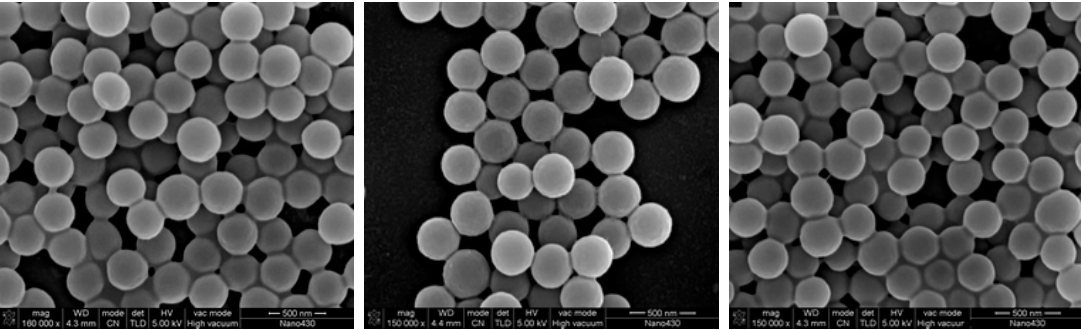
Figure 3. SEM images of different sizes of acrylic polymer nano-latex particles.